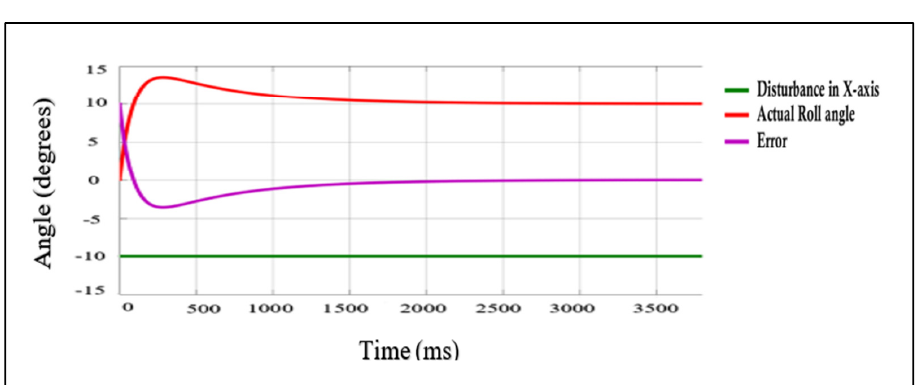
B. under tilt angle -10° on negative X-axis. Fig. 10. Self-balancing behavior of simulated model on X-axis.